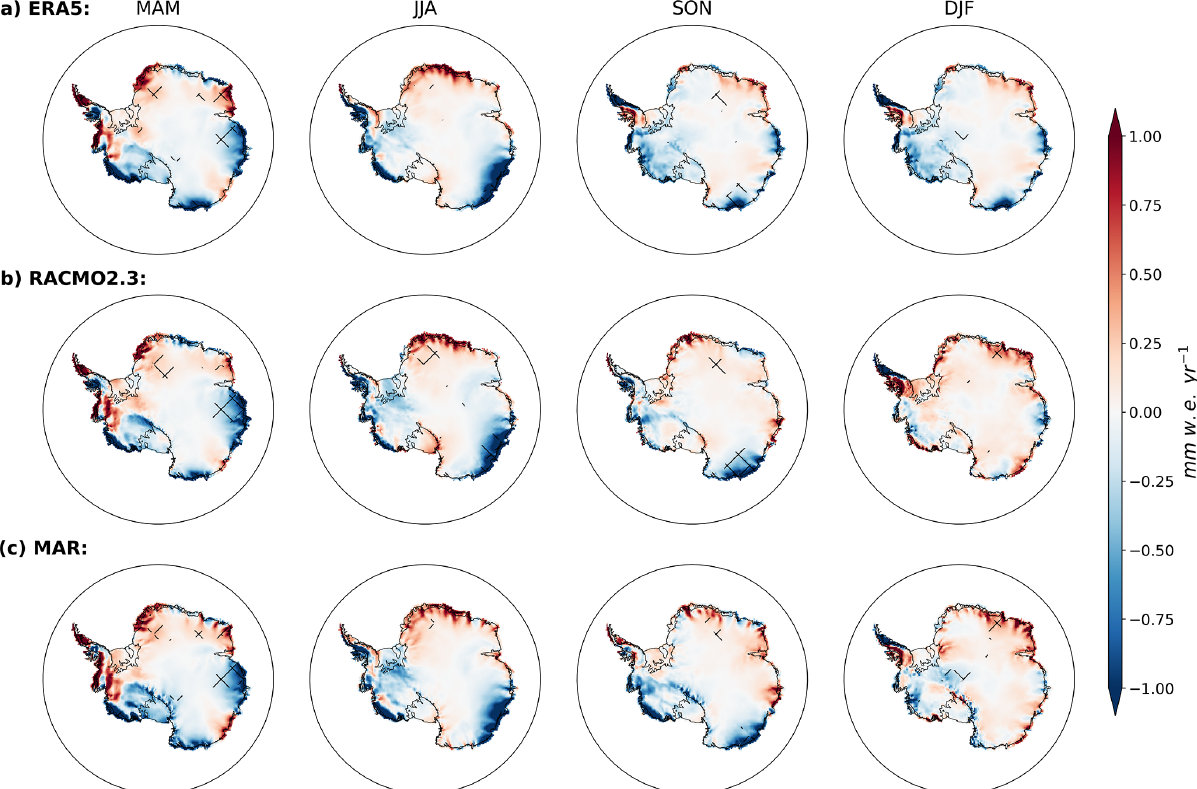
Figure A2. 1979–2015 seasonal trend in precipitation from ERA5 (a) , RACMO2.3 (b) , and MAR (c) . Cross-hatched areas represent regions where this trend is significant ( p < 0.05).